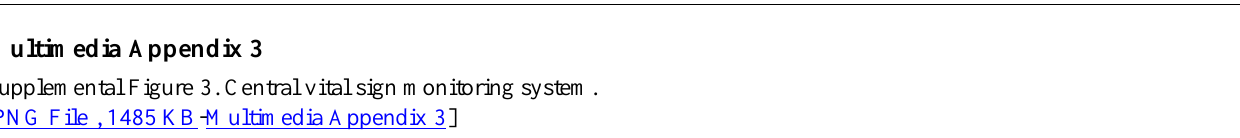
Supplemental Figure 3. Central vital sign monitoring